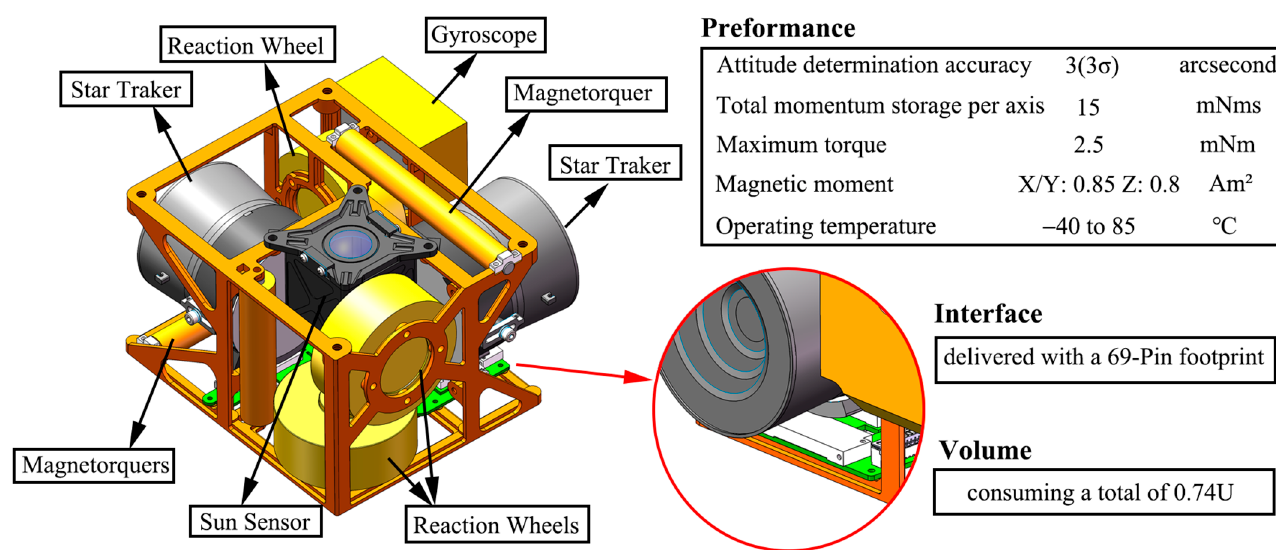
Figure 20. An example IADCS with two DSTs. The IADCS also includes a sun sensor, a gyroscope, three reaction wheels and three magnetorquers. In addition, the performance, interface and volume are listed.